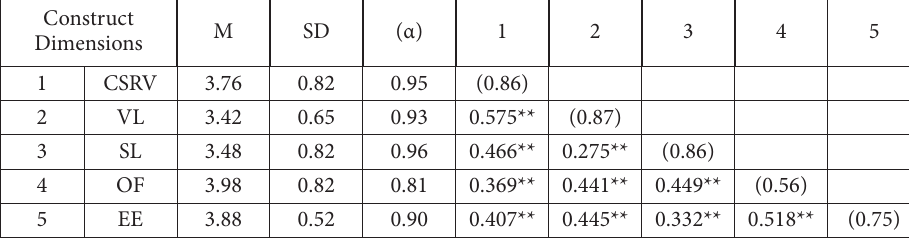
Table 1. Descriptive statistics, reliability and validity estimates, and